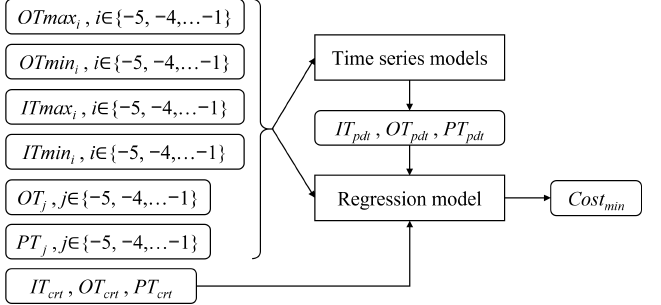
Figure 4. Machine learning models. The inputs and outputs of the models are in the rounded rectangles.